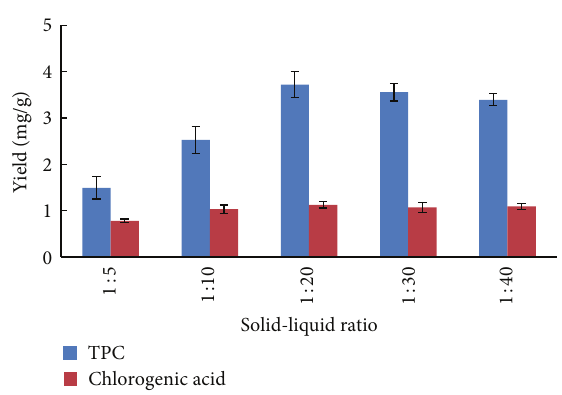
Figure 2: Effect of extraction solvent on TPC and chlorogenic acid yield (solid-liquid ratio, 1:15; extraction time, 30min; number of extractions, 1; 𝑛 = 5 ).